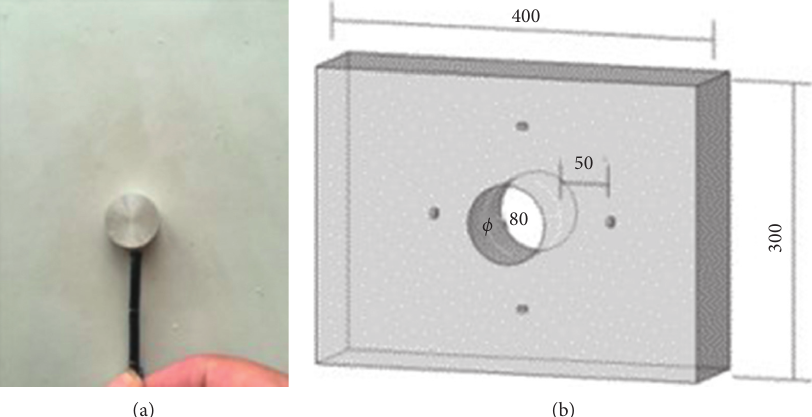
Figure 5: Earth pressure cells and their schematic layout. (a) Miniature Earth pressure chamber. (b) Schematic diagram of Earth pressure box